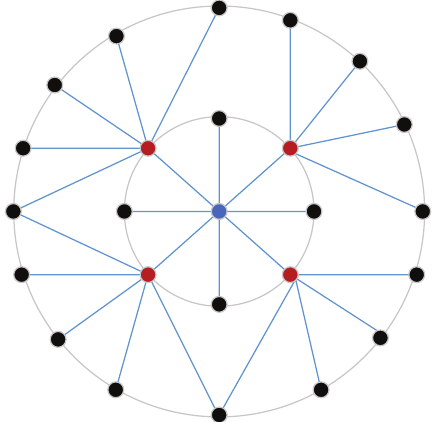
Figure 2: Selected multipoint